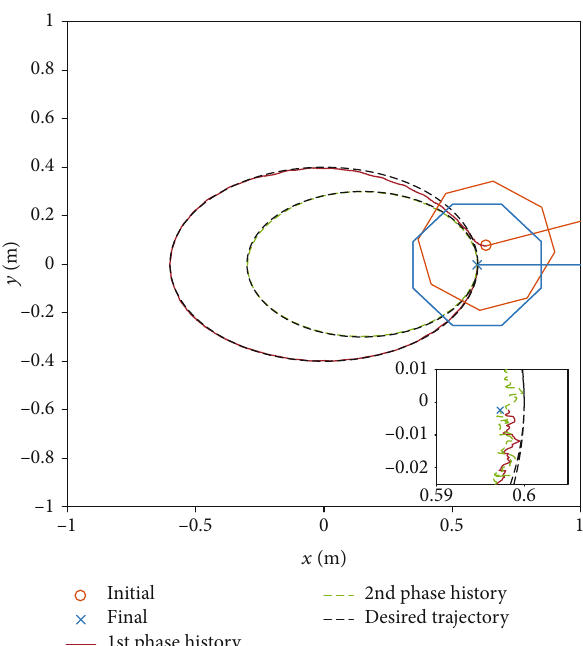
Figure 7: Experimental result: attitude and position of simulator in Case 2.